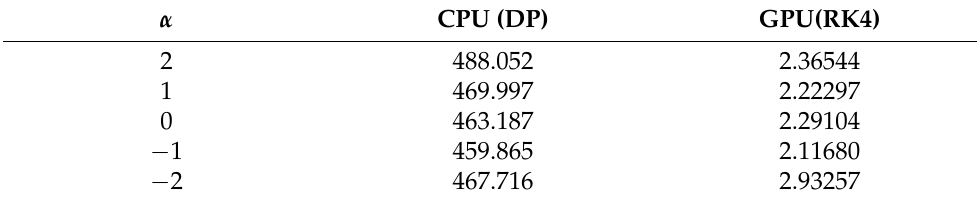
Table 3. Various types of LA Surface and their average LoC’s computation time (in